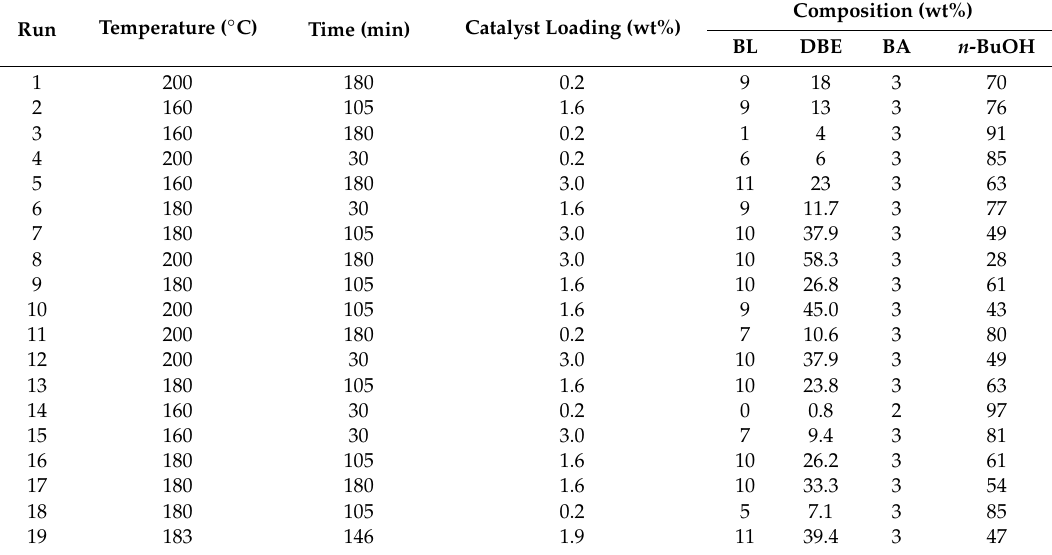
Table 7. Composition of the organic reaction mixtures recovered from the experiments planned for the FCCD and for the model validation, working at the constant biomass loading of 20